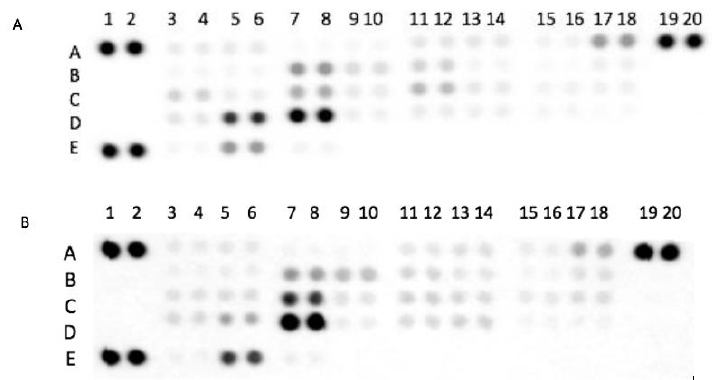
Figure 1. Original membranes of the protease profile in gingival crevicular fluid (GCF) from individuals with ( A ) atopic dermatitis and ( B ) systemically healthy controls ( B ). The following proteases were identified in the membranes: ADAM8 (A3–A4), ADAM9 (A5–A6), Cathepsin E (B3–B4), MMP8 (D5–D6), CD10 (D13–D14), Protein convertase9 (D17–D18), and uPA/Urokinase (E5–E5) with significant differences between both groups. Membranes per group ( n = 6).